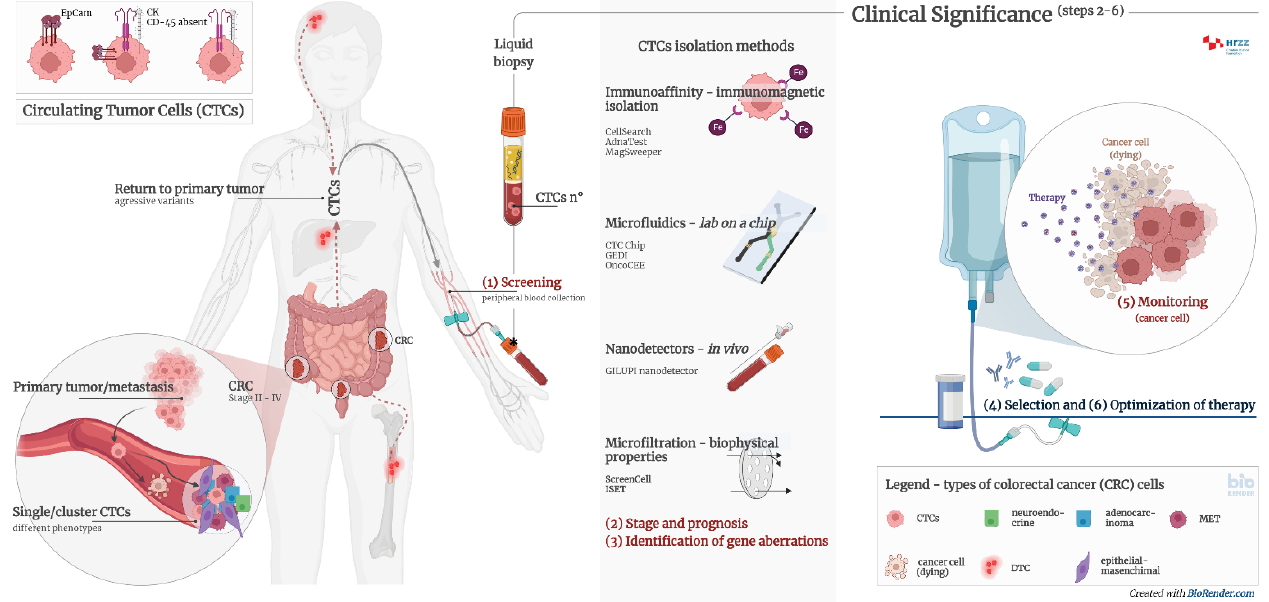
Figure 2. Clinical significance of CTCs and CTC clusters in diagnosis, monitoring, and optimization of therapy in cancer patients. Circulating tumour cells (CTCs) are proven to be prognostically relevant in cancer treatment in colorectal cancer (CRC). Adequate detection and characterization of CTCs can significantly contribute to cancer diagnosis, disease course prediction, therapy selection, and treatment monitoring. (1) Screening—detection of cancer patients by determining the number of CTCs and/or CTC clusters from peripheral blood; (2) stage and prognosis—detection of patients with an increased risk for the development of metastases by determining the number of CTCs and/or CTC clusters from peripheral blood; (3) identification of gene aberrations in CTCs important for therapy, such as mutations in KRAS, APC, EFGR, etc.; (4) selection of therapy—CTC cultivation and selection of effective pharmacotherapy; (5) monitoring—determining the number of CTCs and genome analysis to detect transcriptional changes; (6) optimization of therapy—monitoring the effectiveness of pharmacotherapy and early detection of disease remission by determining the number of CTCs and genome